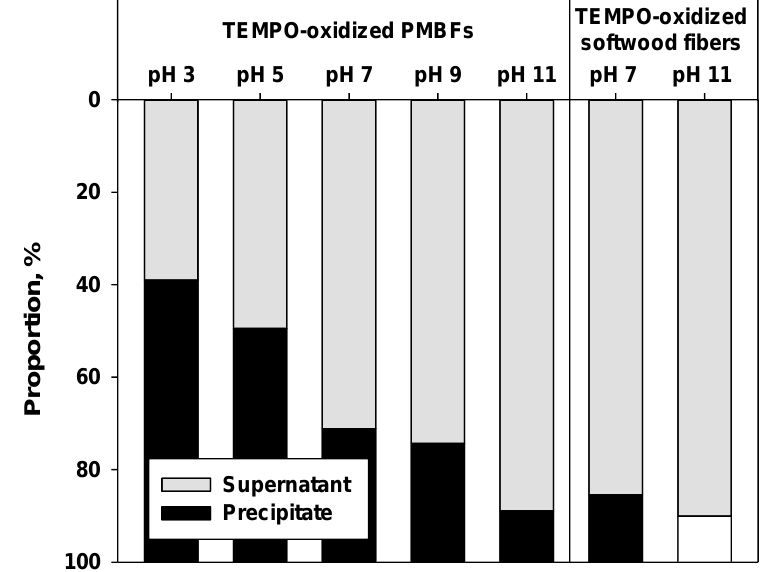
Figure 5. Proportion of supernatant and precipitate after centrifugation of the ultrasonicated suspension of TEMPO-oxidized PMBFs and softwood fibers.